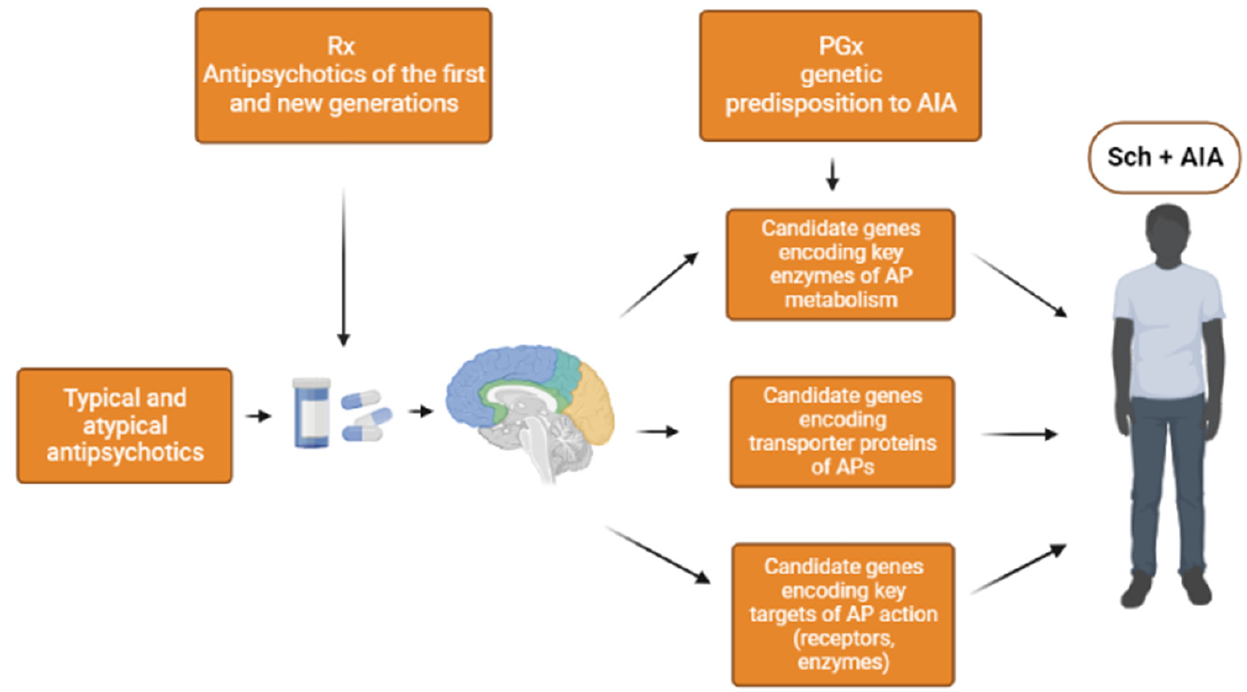
Figure 2. Summary scheme of the genetic predisposition to antipsychotic-induced akathisia (AIA) in patients with schizophrenia (Shc). Note: Rx-prescription and PGx-pharmacogenetics.